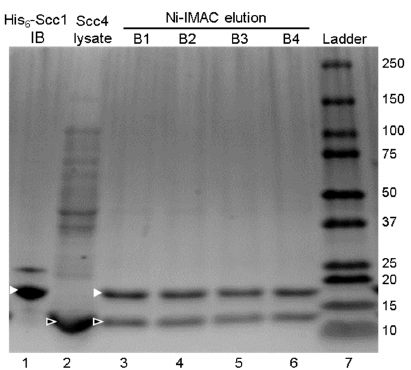
Figure A2. SDS-PAGE analysis of the association of denatured His 6 -Scc1 and Scc4 in lysate using different buffer conditions. Lane 1 is the purified His 6 -Scc1 inclusion body (IB), and lane 2 is clarified cell lysate containing Scc4. Denatured His 6 -Scc1 was diluted with 4 different buffers (B1–B4, described in Section 2.6) before mixing dropwise into the Scc4 lysate. Each mixture was purified using Ni-IMAC to determine if the complex formed; lanes 3–6 are the Ni-IMAC elution samples. The arrow heads indicate bands for His 6 -Scc1 (18.8 kDa) and Scc4 (14.7 kDa). Lane 7 is the Bio-Rad Precision Plus protein ladder with molecular weights listed in kDa to the right.